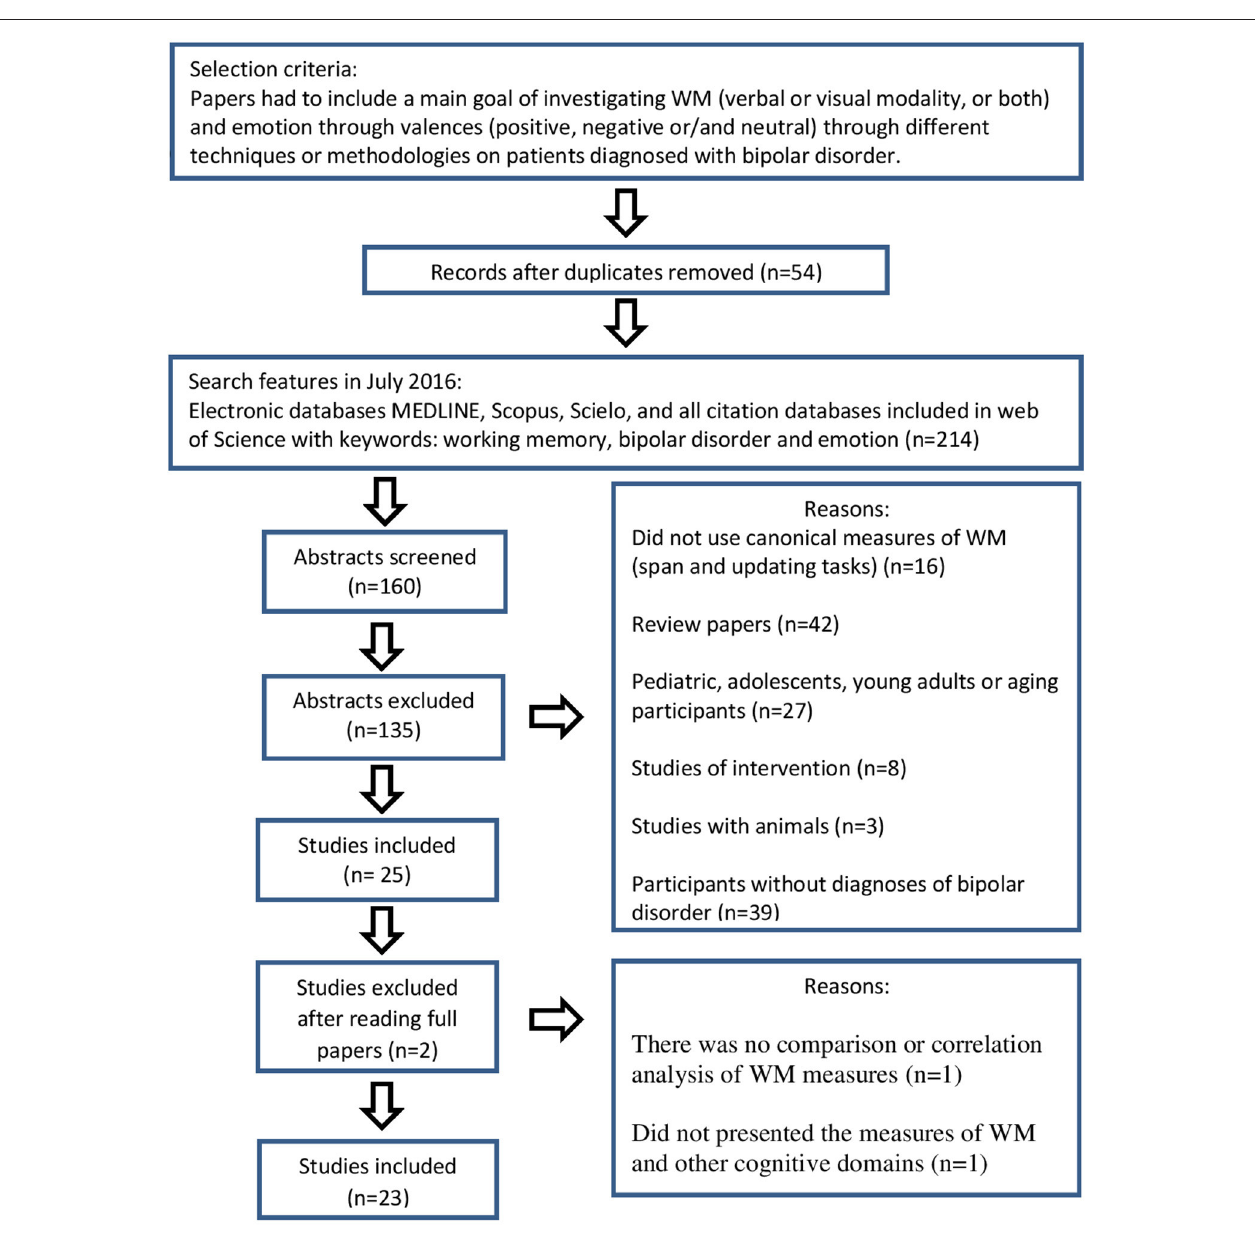
FIGURE 1 | Flowchart of search criteria and articles included in this review. WM, working memory.